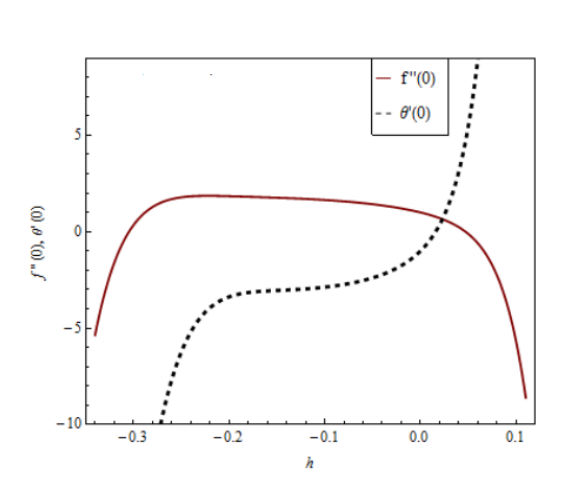
Fig. 2: The (cid:126) curves of dimensionless velocity and dimension- less temperature for alumina-sodium alginate nanofluid with A = 0.5, M = 1, U w = 0.5, ε = 0, Pr = 6.2, ϕ = 0.2, λ = 1.